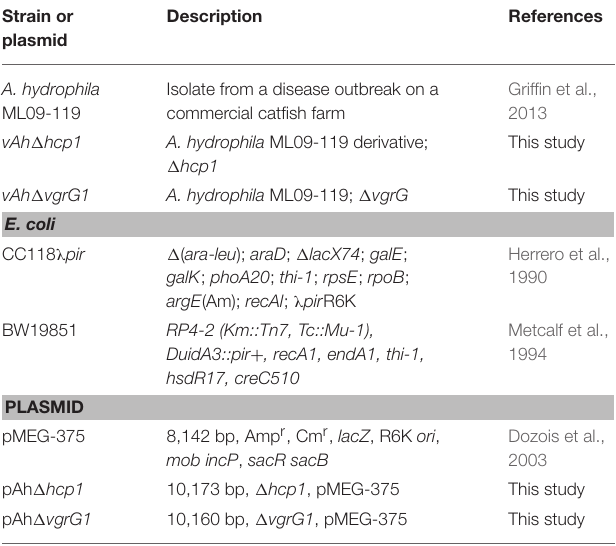
TABLE 2 | Bacterial strains and plasmids used in the present study. Strain or